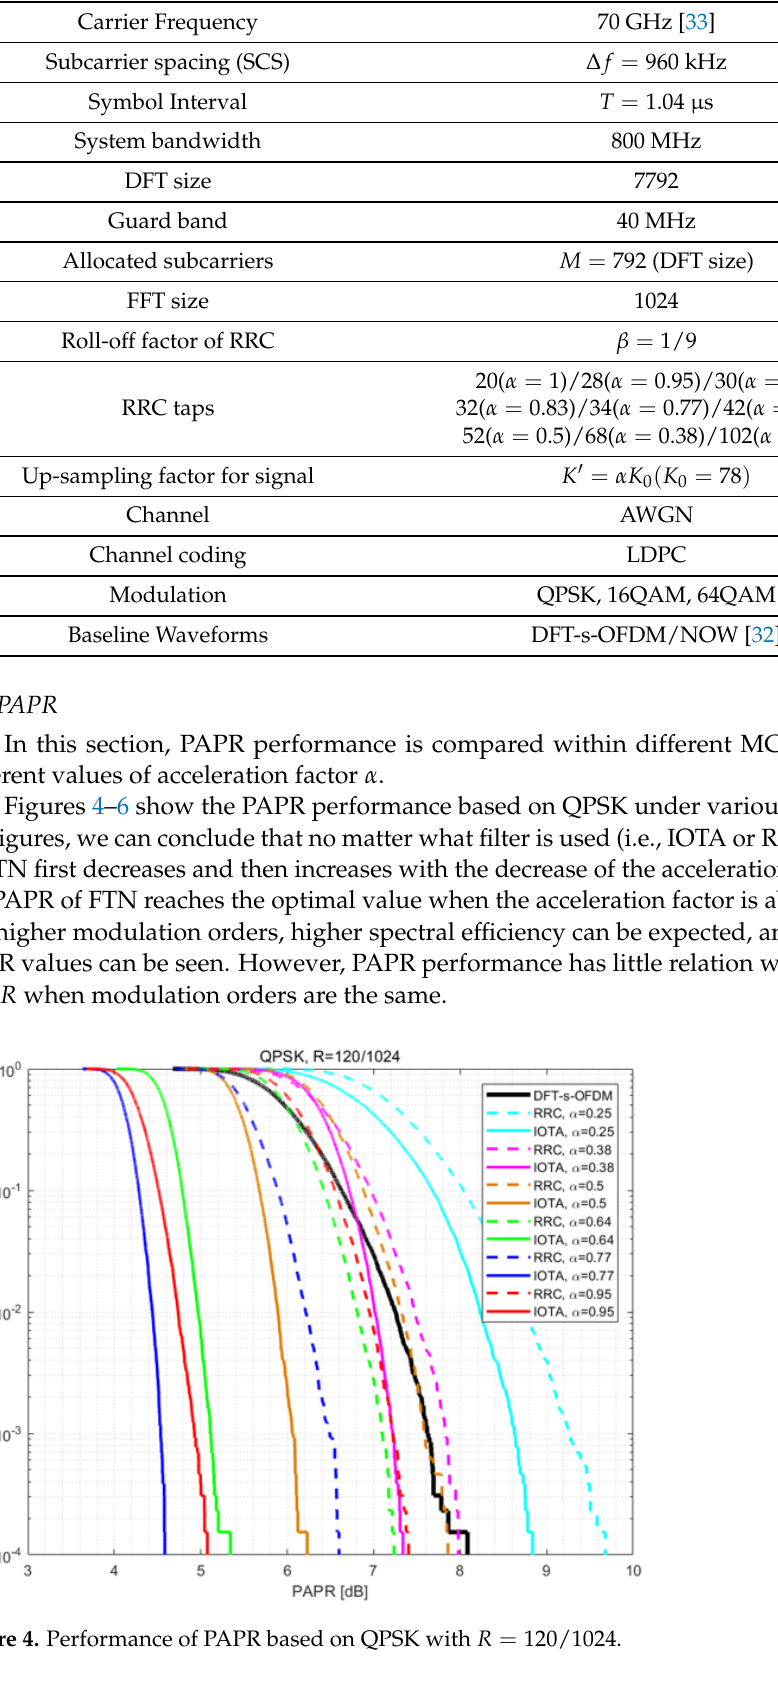
Table 2. Parameters for Simulation.